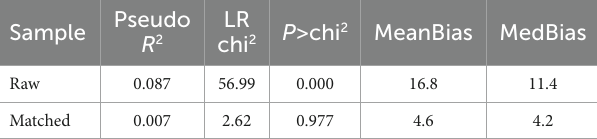
TABLE 3 Matched the results of the pre and post-equilibrium joint tests. TABLE 4 Processing effect of being left behind on children’s SEC.